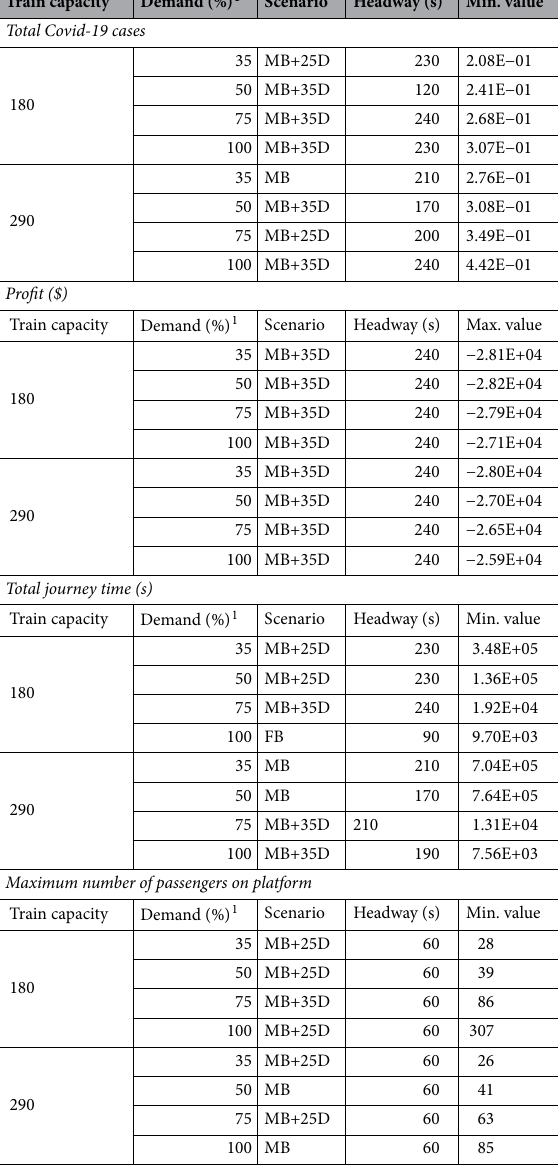
Table 4. Summary of best performing headway and operational scheme for different performance criteria per train capacity and demand level, for baseline Covid-19 crowding multiplier of 1. MB base moving